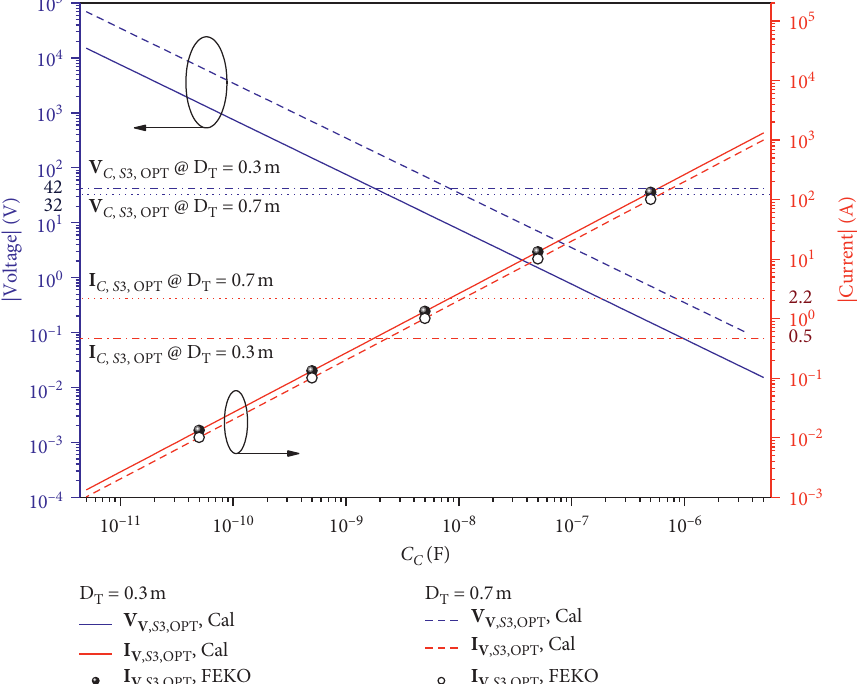
Figure 7: Simulated and calculated source voltage and feeding current in TX